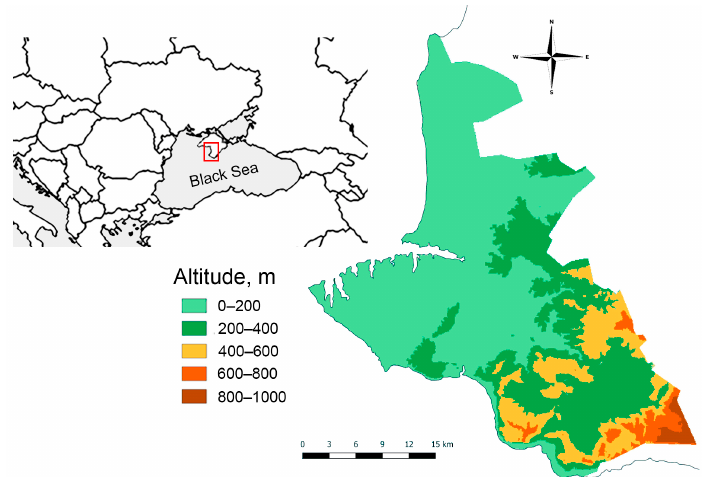
Figure 1. Location of the Sevastopol region.